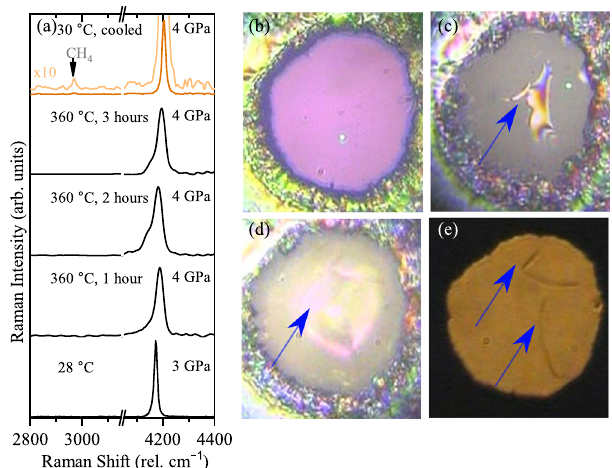
Fig. 2 Raman spectra of resistive heating of hydrogen in a diamond anvil cell at selected pressures and temperatures. a Up to a maximum temperature of 500 °C and held at 300 °C for 2 h and after cooling down. Orange spectra correspond to the cooled down sample. b Up to a maximum temperature of 730 °C and held at 500 °C for 2 h and after cooling down. Orange spectra correspond to cooled down sample. The CH stretching modes of CH 4 ( a ) and C 2 H 6 ( b ) appear between 2900 and 3000 cm − 1 . In the cooled down sample of experiment b , the CH wagging mode is seen at around 1480 cm − 1 . The band at around 4200 cm − 1 corresponds to the vibrational mode of H 2 ( Q 1 50 , this is accompanied by the rotational + vibrational band ( Q 1 + S 0 ) visible in liquid hydrogen. At high temperatures, there is another band at lower frequency, which corresponds to the thermally populated second vibrational state of hydrogen 51 . Asterisks mark the vibrational mode from the CH 4 -H 2 van der Waals compounds 41 .